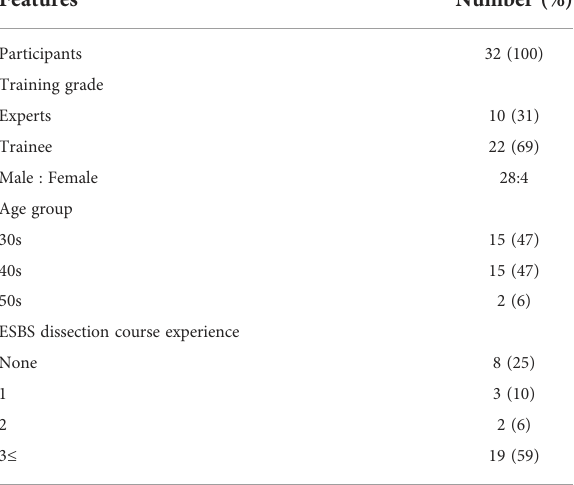
ESBS, endoscopic skull base